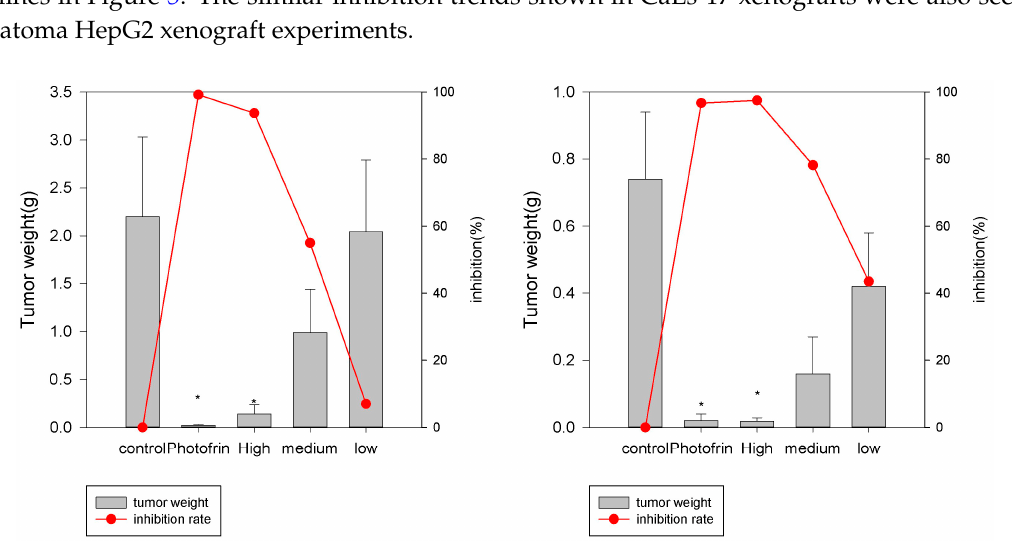
Table 4. Tumor volumes, RTV and T/C values in hepatoma HepG2 xenograft experiments.